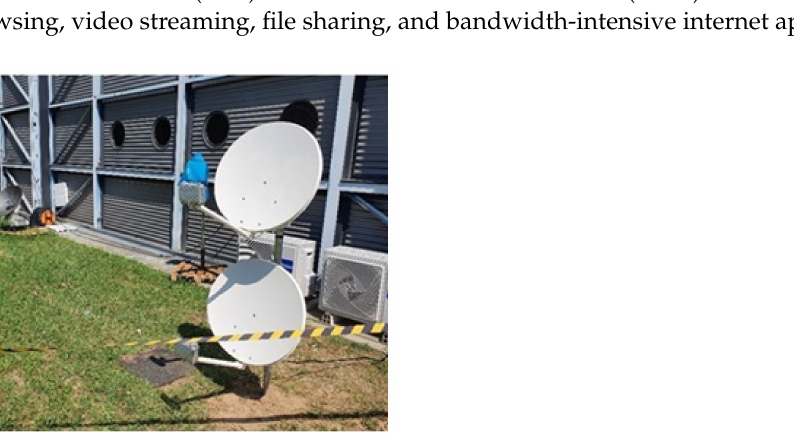
Figure 15. B-LiFE deployment in Turin, Italy, during the COVID-19 crisis: installation of 2 Eutelsat SatCom